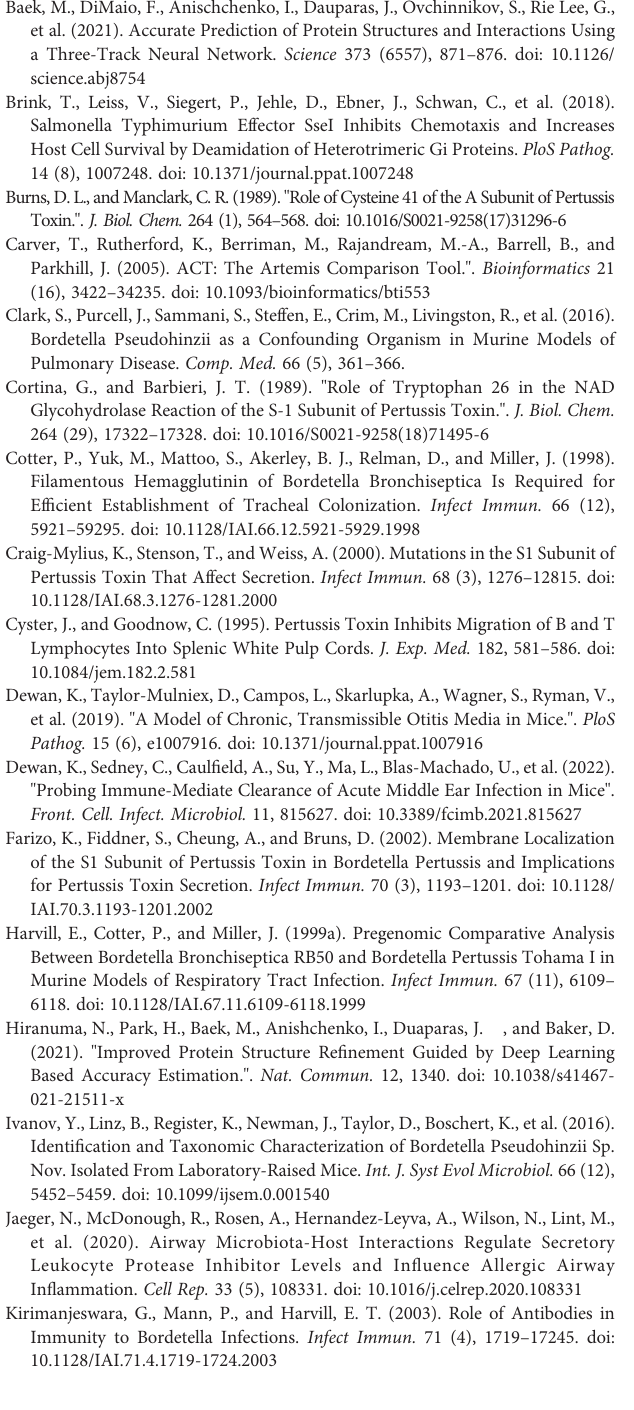
Supplementary Figure 5 | Bio fi lm forming abilities of WT and mutant B. pseudohinzii. WT B. pseudohinzii (WT Bpsu) (red) and B. pseudohinzii Δ psxA (Bpsu Δ psxA) (blue) demonstrate similar bio fi lm forming capabilities after 48 hours in